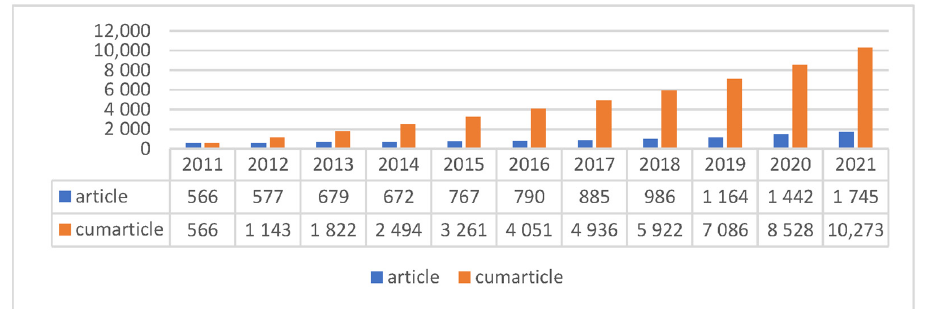
Figure 1. Annual publications concerning Health Education (HE) in the Web of Science (WOS TM ).